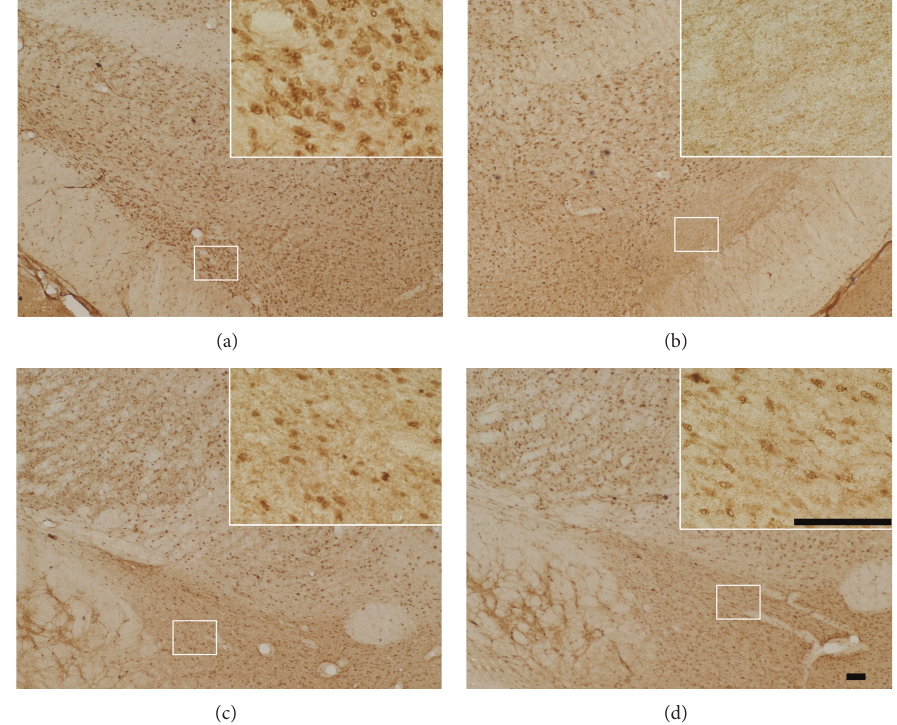
Figure 7: Immunohistochemistry of hGAD65 in the STN (DAB, bar = 100 𝜇 m). A large number of hGAD65-positive cells are observed in the left STN (a, c, and d) of rAAV2-hGAD65 groups, but there are no positive cells in either hemispheres of the TH group (b). The number of hGAD65-positive cells decreased according to posttreatment time: 4 weeks (a), 8 weeks (c), and 16 weeks